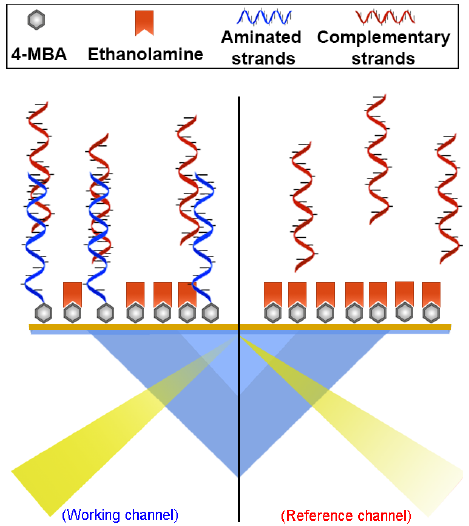
Figure 1. Schematic representation of the biosensor constructed, showing the working channel ( left side ), composed of a monolayer of 4-mercaptobenzoic acid, aminated thrombophilia strands, and ethanolamine, and the reference channel ( right side ), composed of 4-mercaptobenzoic acid and ethanolamine, and the interactions with complementary thrombophilia strands.